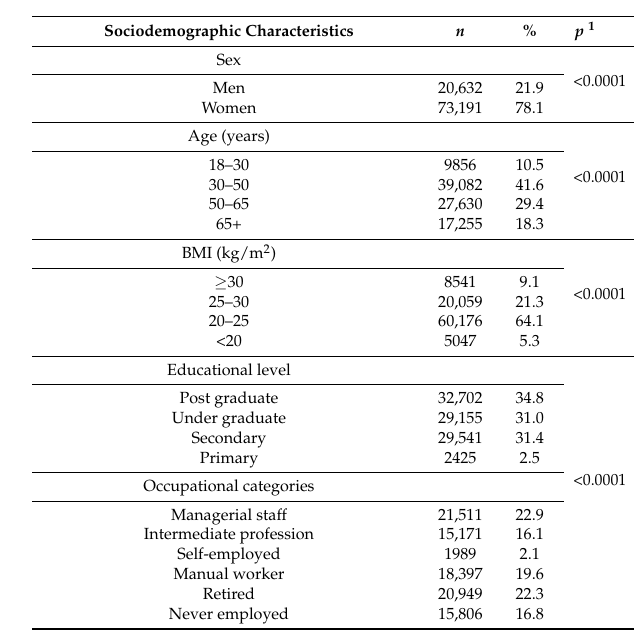
Table 1. Sociodemographic characteristics of the sample (Nutrinet-Sant é Study 2009–2015, n =